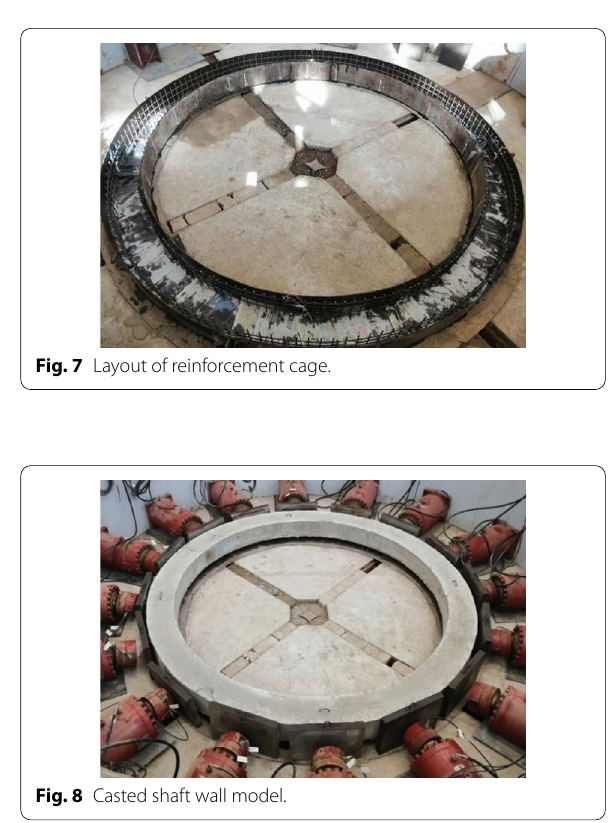
Fig. 8 Casted shaft wall